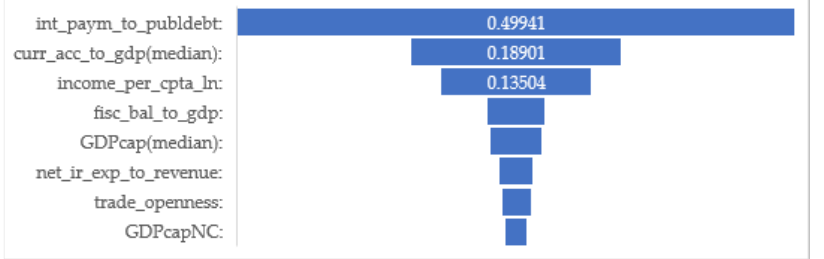
Figure 3. Random Forest Regression ver. 2.0 — Parametric assessment of the factor influence of selected indicators on the government debt-to-GDP ratio. Source: authors’ calculations.